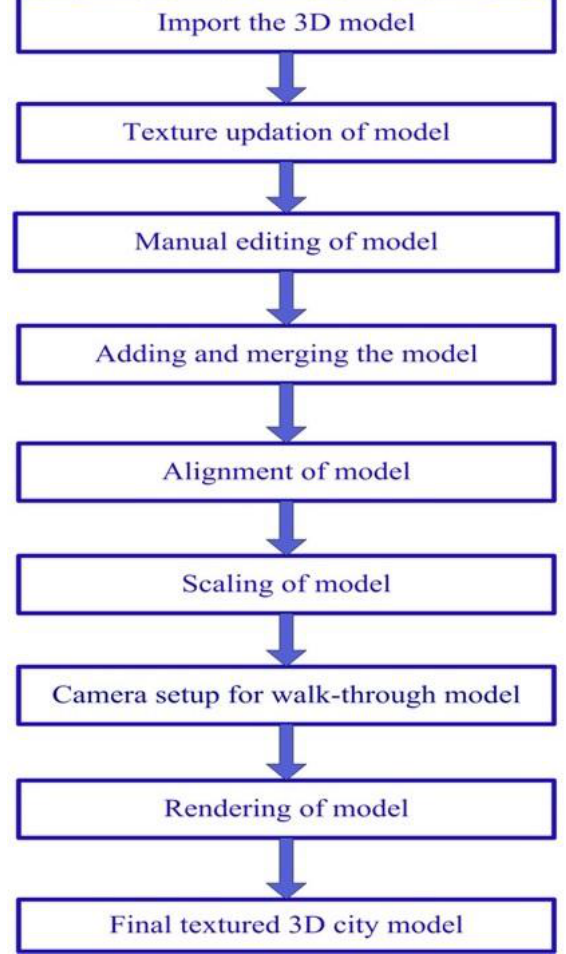
Figure 17: Flow diagram of methodology for data